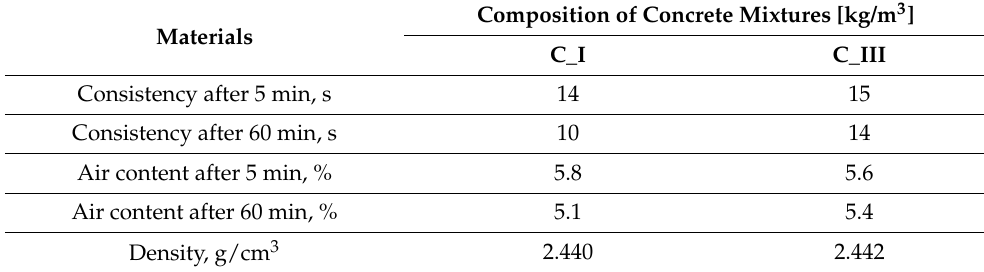
Table 5. Properties of the concrete mix.